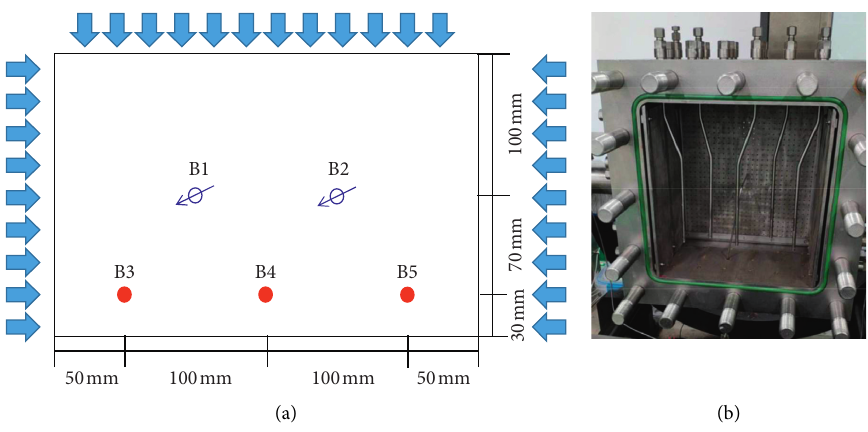
Figure 2: Well location of the 3D physical simulation experiment.